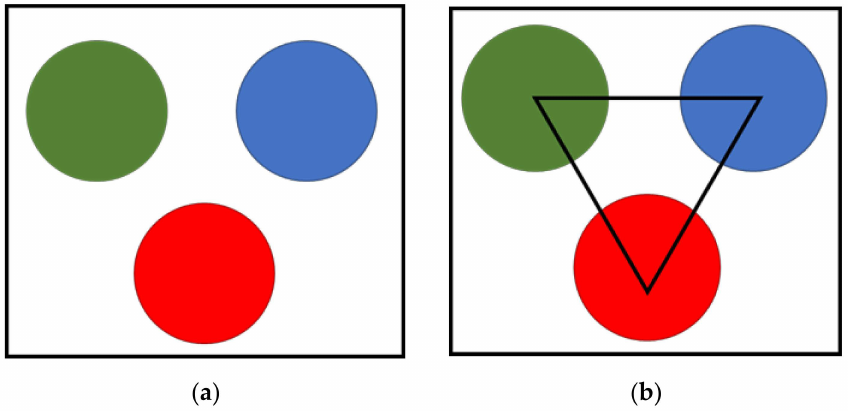
Figure 8. Marker for the docking system. ( a ) Circular marker for Cabin Docking, ( b ) connecting the center point of the circular marker.